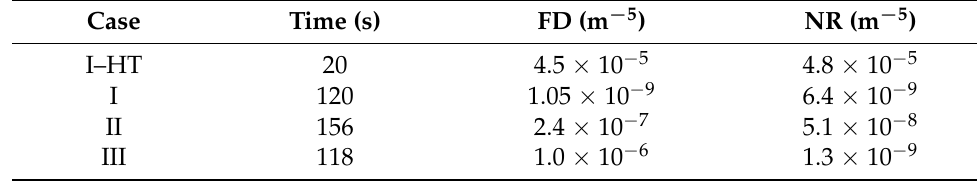
Table 3. Values of the integrated Laplacian squared in Equation (8) for the bandwidth of kernel K 1 in Equations (37) and (38) with finite differences (FD) or the normal reference rule (NR). The case column refers to the case in Table 1. The time column gives the simulated time at which the integral is